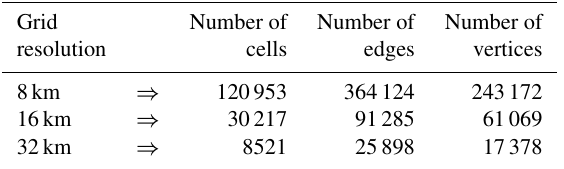
Table 1. Data corresponding to the three SCVT meshes used in the wind-driven gyre experiment. Grid Number of Number of Number of resolution cells edges vertices 8km ⇒ 120953 364124 243172 16km ⇒ 30217 91285 61069 32km 8521 25898